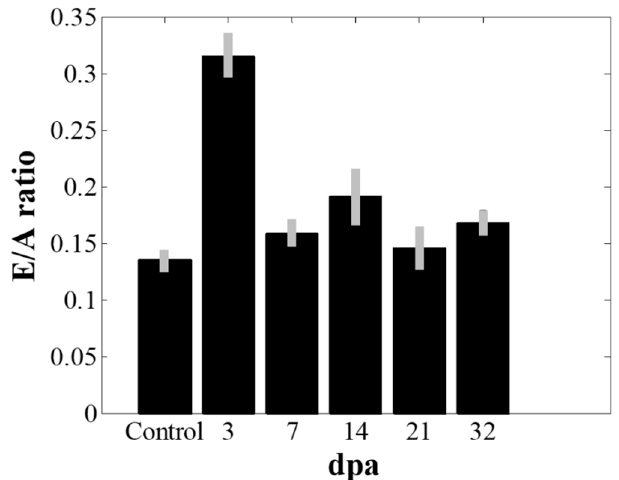
Figure 5. The changes of the E / A ratio values that represents the ratio of the peak velocity of blood flow in the early diastole ( E -flow) to the peak velocity in the late diastole via atrial contraction ( A -flow) before and after amputation. The E / A value increased at 3 dpa ( p -value < 0.05) and recovered to the value before amputation. The error bars indicate the standard deviation in the data from five zebrafish.